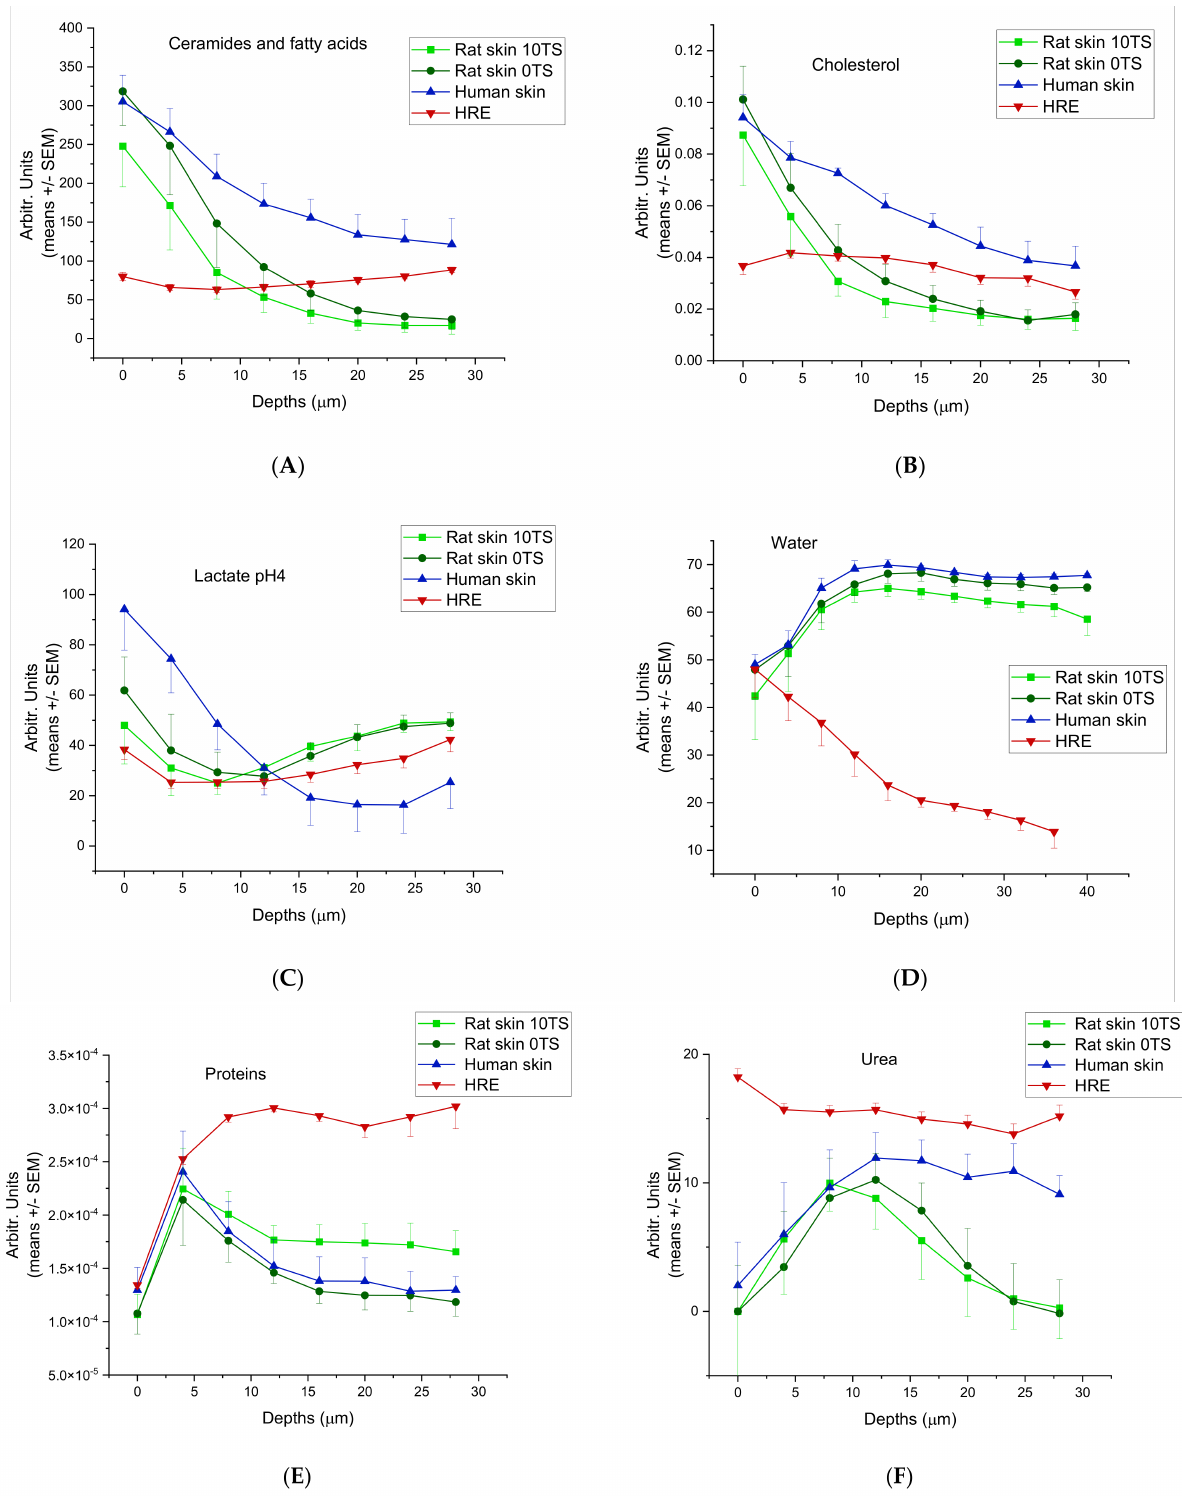
Figure 4. Skin composition profiling in 0–28 µ m (for water 0–40 µ m) depths from the outermost surface of Stratum corneum in intact (0TS) and mechanically pretreated (10TS) rat skins and intact human skin after freezing and thawing and also in in vitro skin substituents (HRE). ( A ) Ceramides and fatty acids, ( B ) cholesterol, ( C ) lactate (pH = 4), ( D ) water, ( E ) proteins, ( F ) urea. The experiments were performed in duplicates (in HRE) or in triplicates (in rat and human skins) using N = 8–10 different positions for z-profiling on all